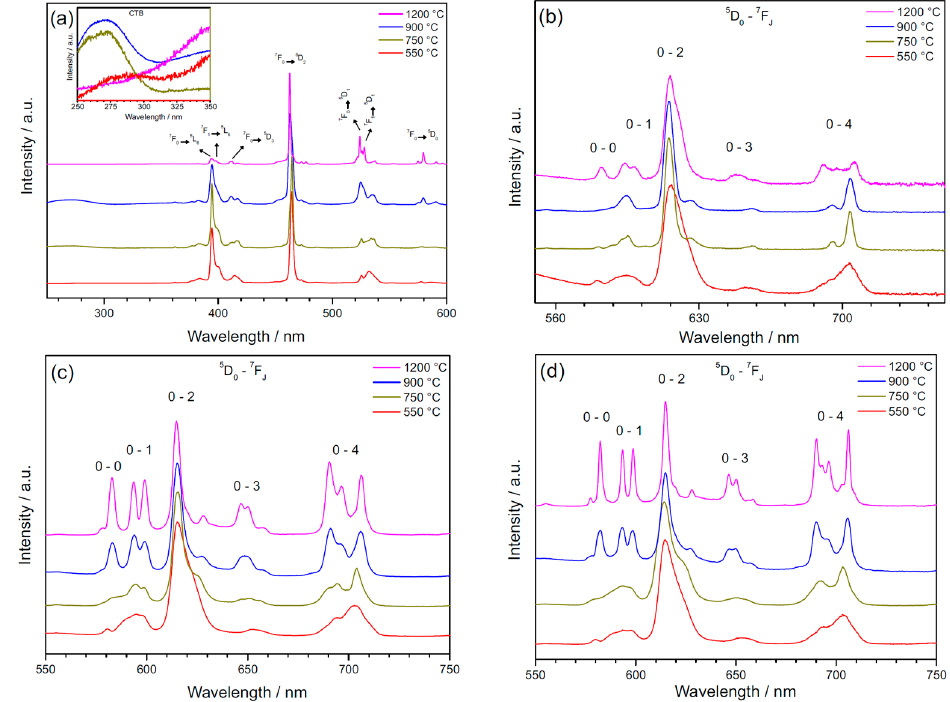
Figure 4. Luminescence spectra of the Nb 2 O 5 :La (0.9%) Eu (0.1%) sample heat treated at varying temperatures: ( a ) Excitation spectra ( λ em: 614 nm); ( b ) emission spectra ( λ exc: 275 nm); ( c ) emission spectra ( λ exc: 394 nm); ( d ) emission spectra ( λ exc: 465 nm) and € emission spectra ( λ exc: 525 nm) [88].